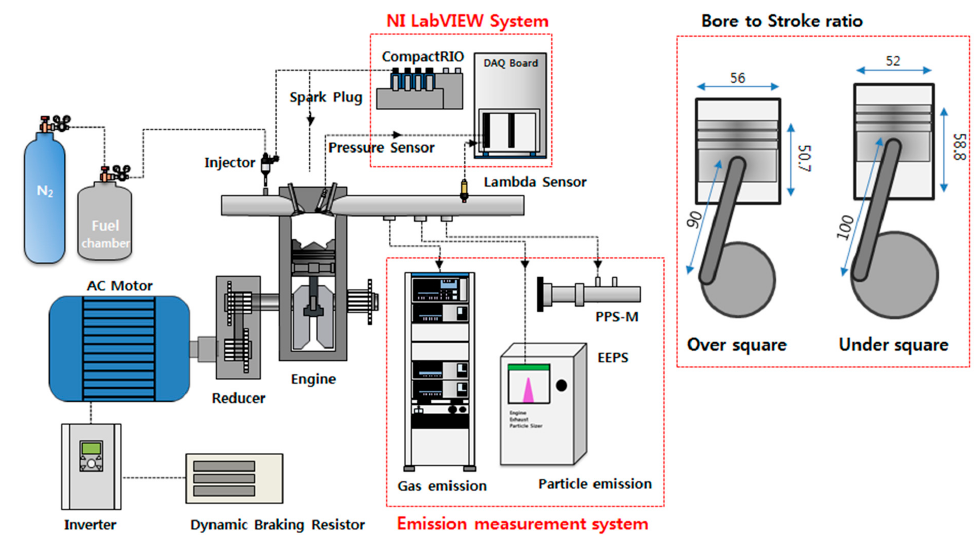
Figure 1. Schematic diagram of the engine test system. Table 1. Specifications of the test engines.